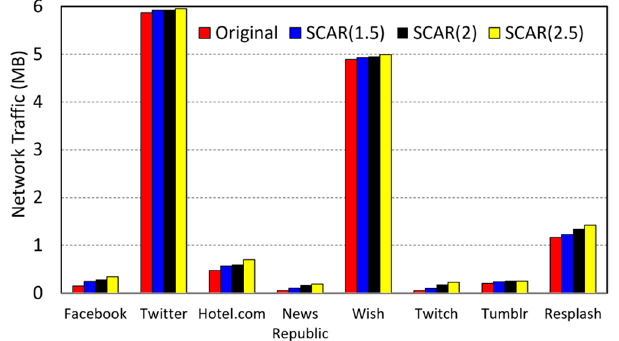
Figure 17. Network traffic upon the launching of a scrolling window.